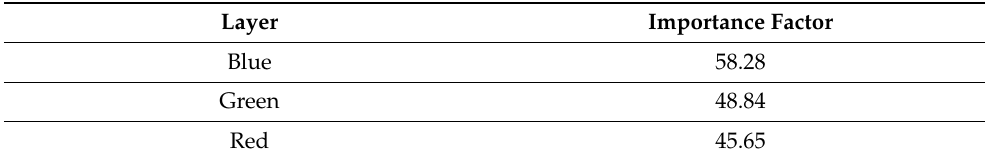
Table 4. Sum of decreases in Gini impurity